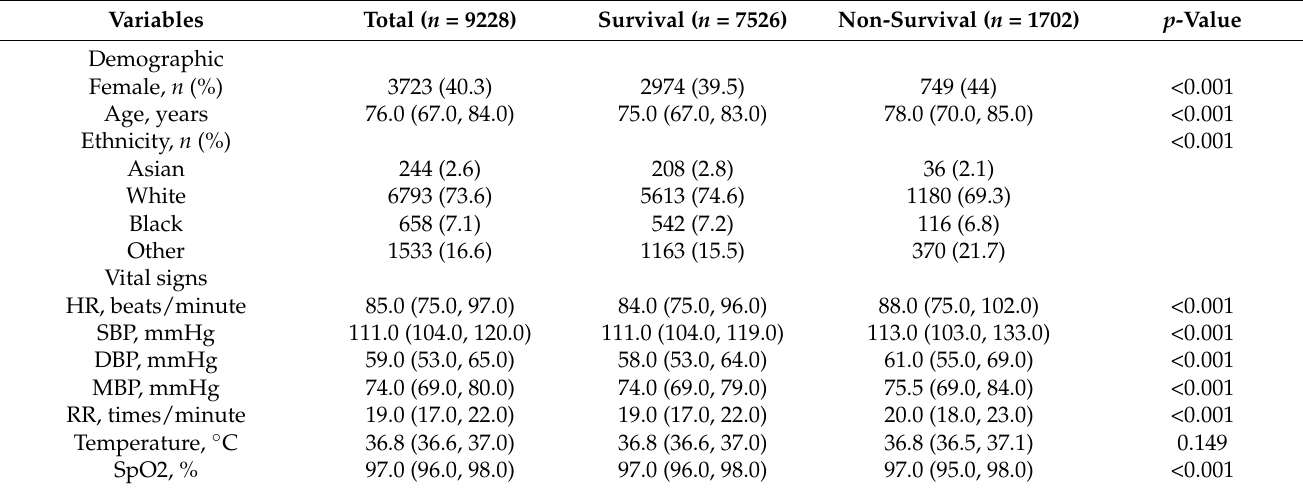
Table 1. The baseline clinical characteristics of septic patients with atrial